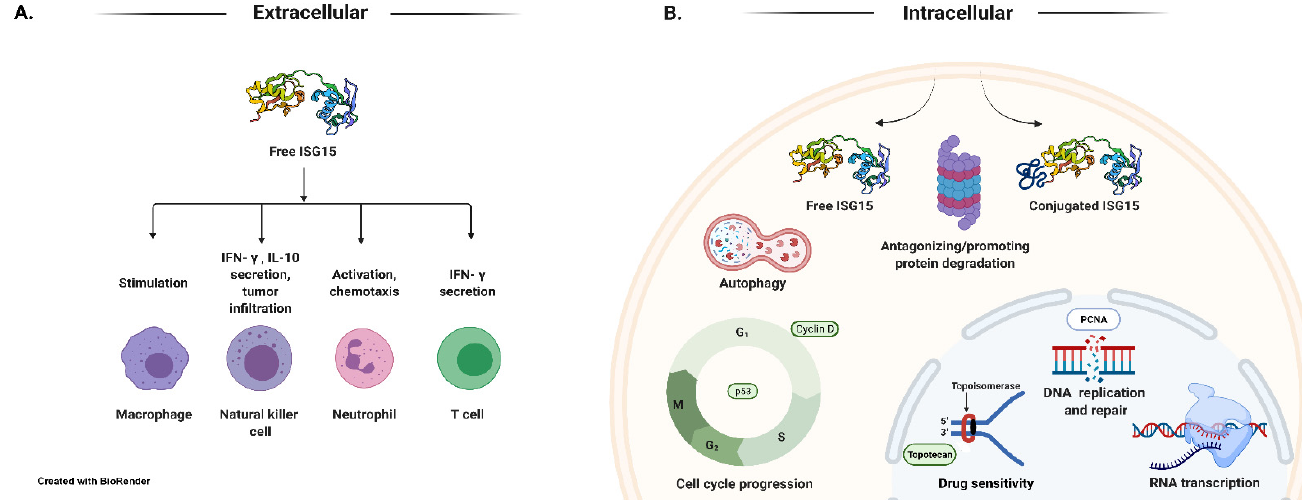
Figure 2. Functions of free and conjugated ISG15. ( A ) Extracellular free ISG15 serves as an im- munomodulatory cytokine secreted in response to type I interferon induction [63,64]. ISG15 stimu- lates the production of IFN- γ in bovine peripheral blood mononuclear cells [60,106], T lymphocytes, and CD3 + T cells [63,107]. ISG15 stimulates the proliferation of CD56 + natural killer cells in the pres- ence of CD3 + T cells, which leads to an enhanced lymphokine-activated non-major histocompatibility complex-restricted target cell lysis [63]. The binding of ISG15 to the LFA1 receptor on NK cells stimu- lates the release of IFN- γ and IL-10 from IL-12 primed NK cells [80]. Secreted ISG15 can also influence neutrophil chemotaxis [108]. ( B ) Free ISG15 protein synthesized from the ISG15 gene is found in cells in its free and conjugated intracellular forms. Intracellular free ISG15 stabilizes (e.g., USP18) or destabilizes (e.g., Cyclin D1) some cellular proteins [72,109]. Intracellular ISG15 conjugates to a multitude of targets within the cell upon interferon stimulation. These protein targets are involved in every facet of cellular function, including DNA replication/repair, metabolism, signal transduction, and cytoskeletal organization, among several others [73,110–113]. The majority of the nuclear targets for ISG15 are involved in chromatin remodeling/RNA polymerase II transcription or RNA process- ing [114]. Protein ISGylation inhibits proteasome-mediated protein degradation and increases protein degradation by selective autophagy [70,76,115–117]. ISGylation confers topoisomerase-targeted drug sensitivity to tumor cells [74]. The consequences of ISGylation for ubiquitin-mediated protein degradation of substrates are variable and may be context-specific.